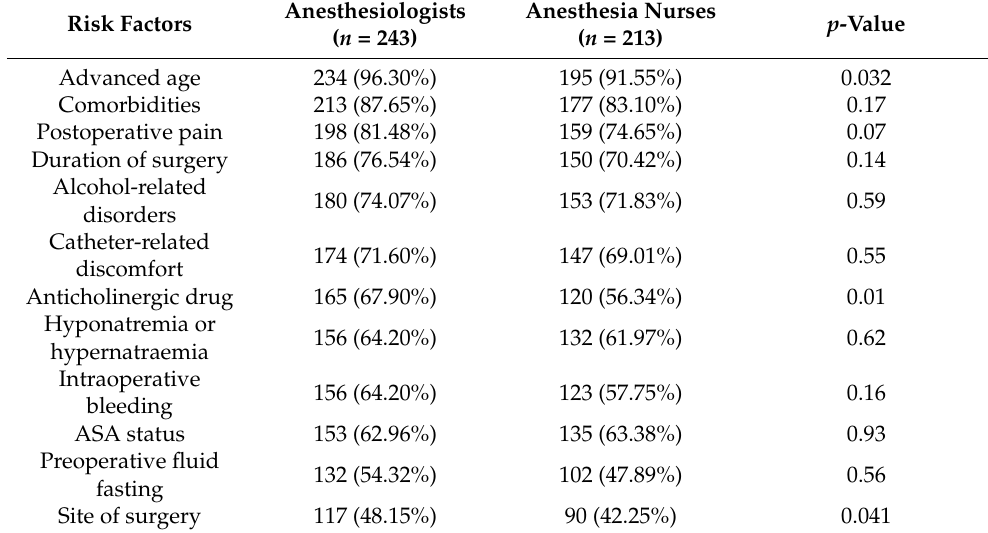
Table 2. Reported risk factors associated with emergence delirium.